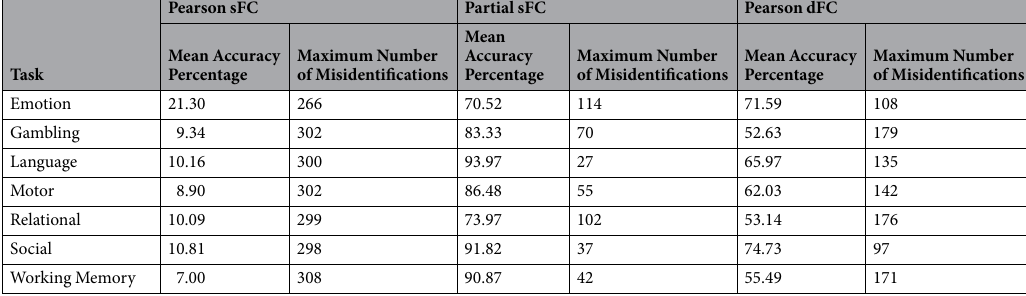
Table 4. Comparison of 3T rfMRI (baseline) and 3T tfMRI (target) mean subject identification accuracy percentages.